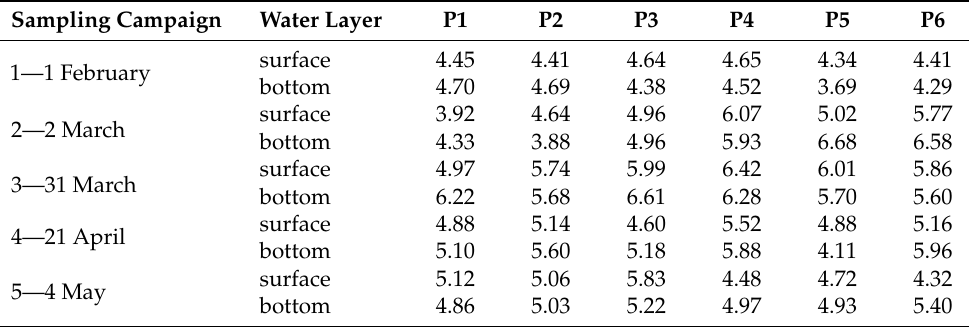
Table 4. LogK D (L kg − 1 ) for Hg in the surface and bottom water samples collected at the six investigated sites in the Bay of Panzano under different environmental conditions.